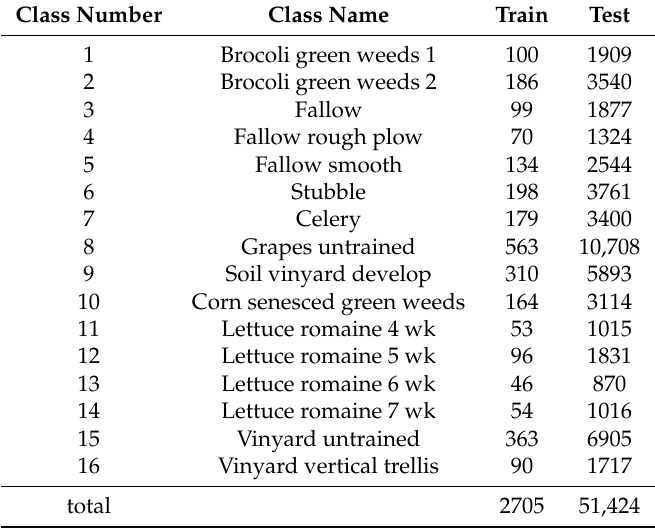
Table 2. Groundtruth classes for Salinas scene and the corresponding number of training samples and testing samples for classification experiments.